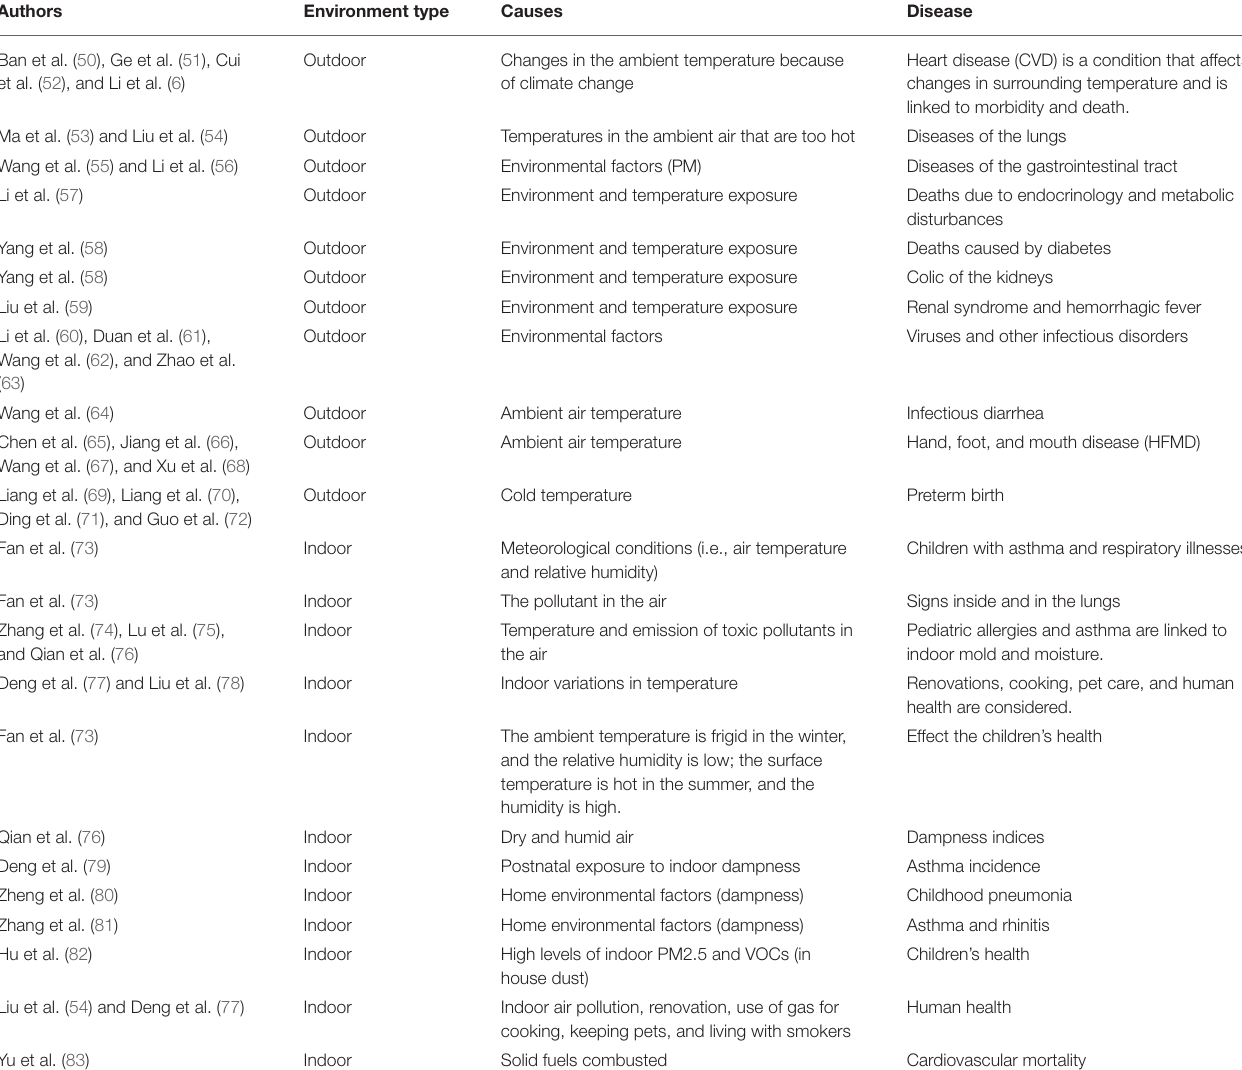
TABLE 2 | Literature summary on the outdoor and indoor environment, their causes, and health